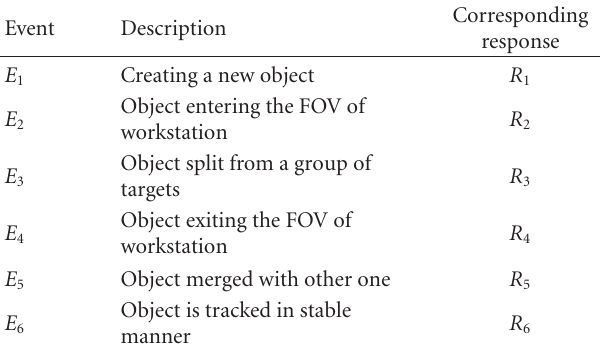
Table 1: Tracking events used, their meanings, and their